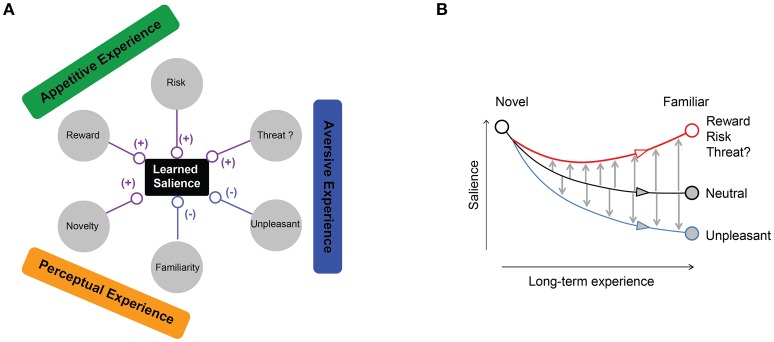
Multiple ecological factors influencing objects learned salience. (A) Appetitive dimension (reward amount or risk) enhances object salience. Aversive dimension enhances or suppresses object salience depending on the outcome type. Mere perceptual exposure suppresses object salience compared to novel objects. (B) Proposed dynamics of salience modification by ecological experience. Novel objects lose their salience through perceptual exposure (black line). Non-threatening but unpleasant outcomes further decrease object salience compared to neutral familiar objects. Rewarding, risky, or threatening outcomes counteract familiarity and enhance object salience.